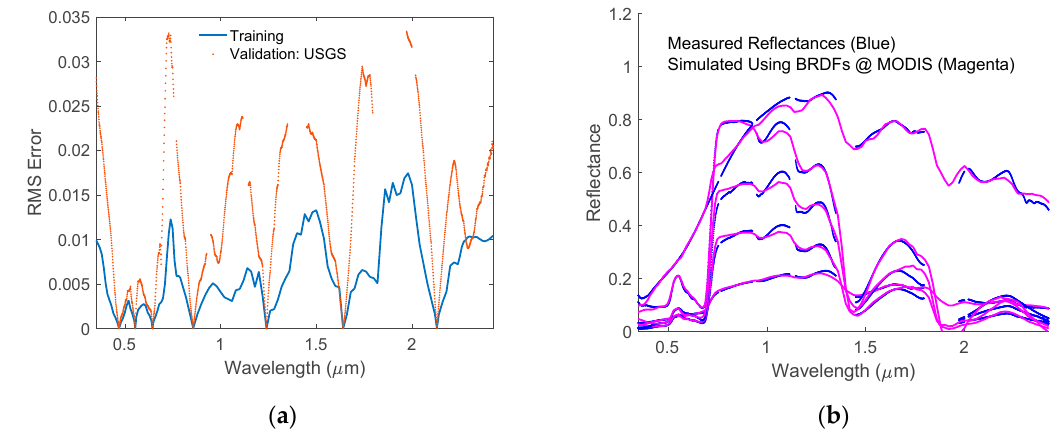
Figure 9. ( a ) The RMS errors of simulated spectra using HSBR model with respect to experimental measurements in the USGS vegetation database; ( b ) Randomly picked experimental reflective spectra from USGS vegetation database (-) and the corresponding simulated spectra obtained using HSBR model (--).